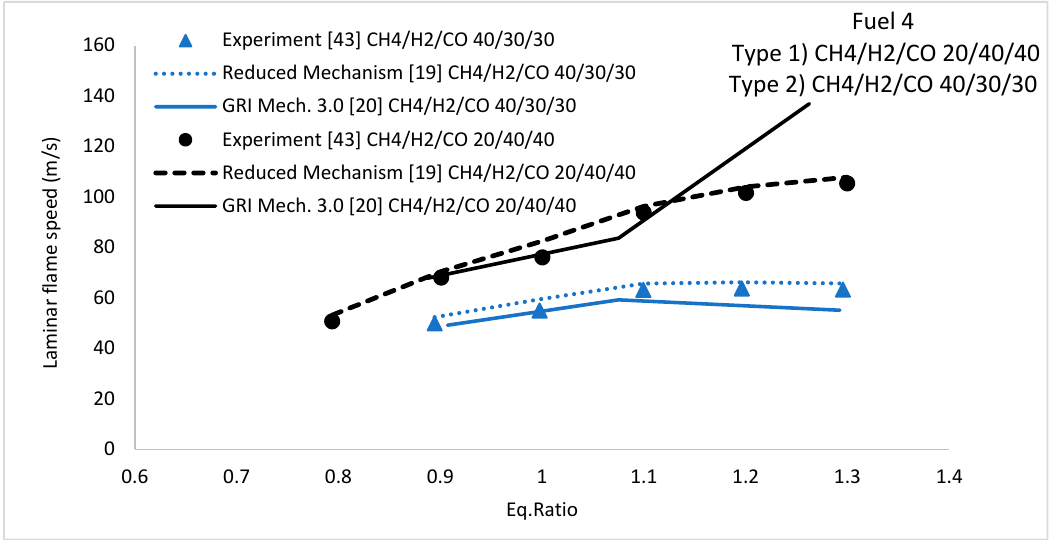
Figure 6. Comparison of the calculated laminar flame speed using the reduced mechanism [19] and GRI Mech. 3.0 [20] and the experimental measurements from Reference [43] for Fuel 4 (CH 4 / H 2 / CO 40 / 30 / 30% and 20 / 40 / 40%), at pressure 1 bar, eq.ratio 0.7–1.3 and temperature 295